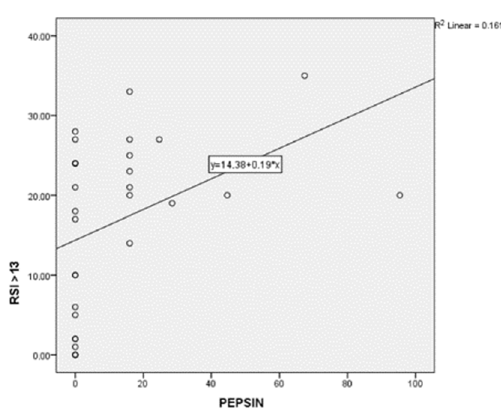
Figure 2. Group A patients showed a statistically significant higher value of Pepsin ( p = 0.027).